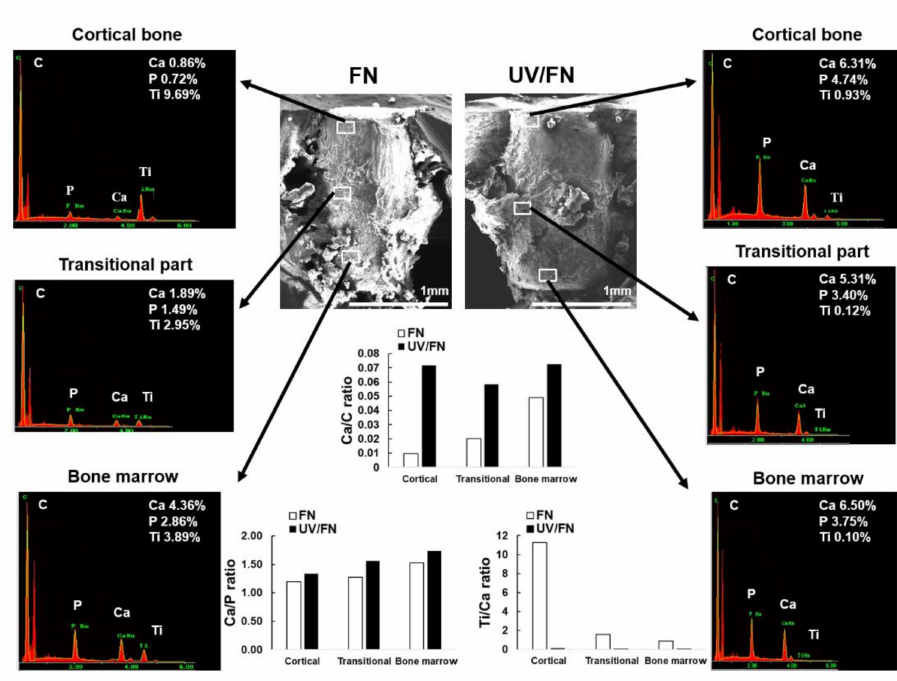
Figure 7. Morphology and elemental analyses of fibronectin-adsorbed (FN) and UV-treated and fibronectin-adsorbed (UV / FN) implant interfaces at the early healing stage of week two. A 1-h adsorption protocol was used. Implants were retrieved after the push-in test; the tissue interfaces were exposed and analyzed by scanning electron microscopy (SEM) and energy-dispersive X-ray spectroscopy (EDS). FN-adsorbed and UV / FN-treated implants were compared. Third zones of the implant from each of the superior (cortical), mid (transitional), and apical (bone marrow) areas are presented with the EDS spectrum obtained from the respective areas. The arrows show the results of the EDS analysis in those areas. Calculated Ca / C, Ca / P, and Ti / Ca ratios are also presented. Scale bar = 1